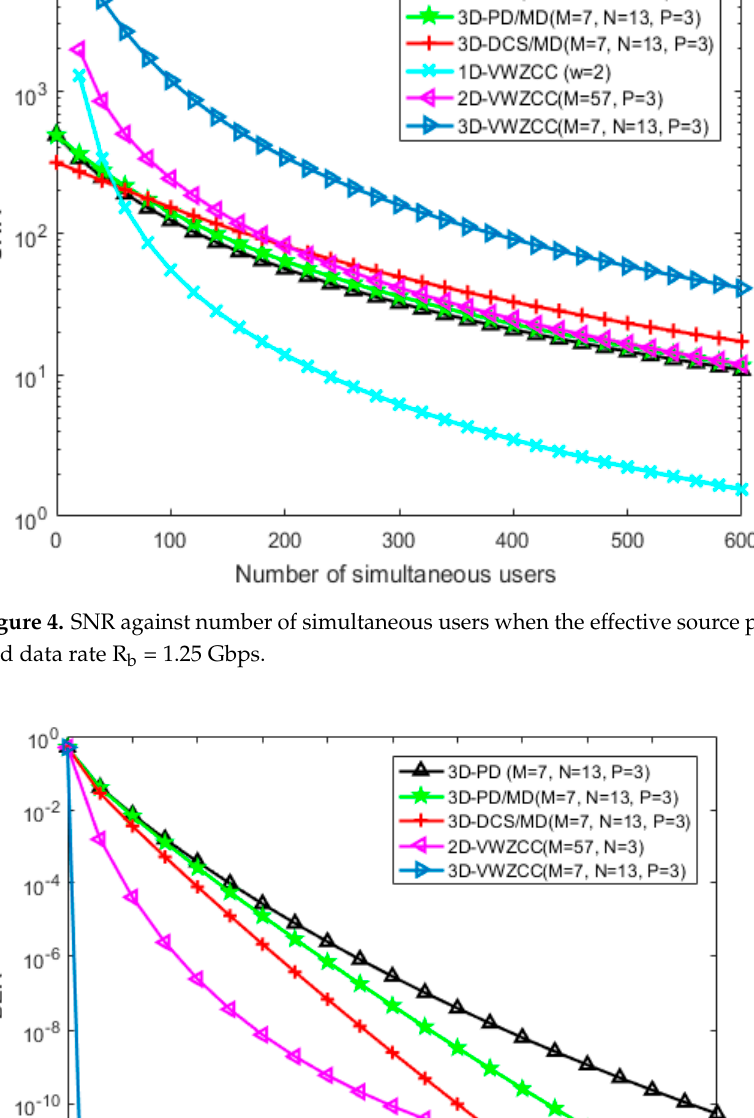
Figure 4. SNR against number of simultaneous users when the effective source power P (cid:2929)(cid:2928) = − 10 dBm and data rate R (cid:2912) = 1.25 Gbps.